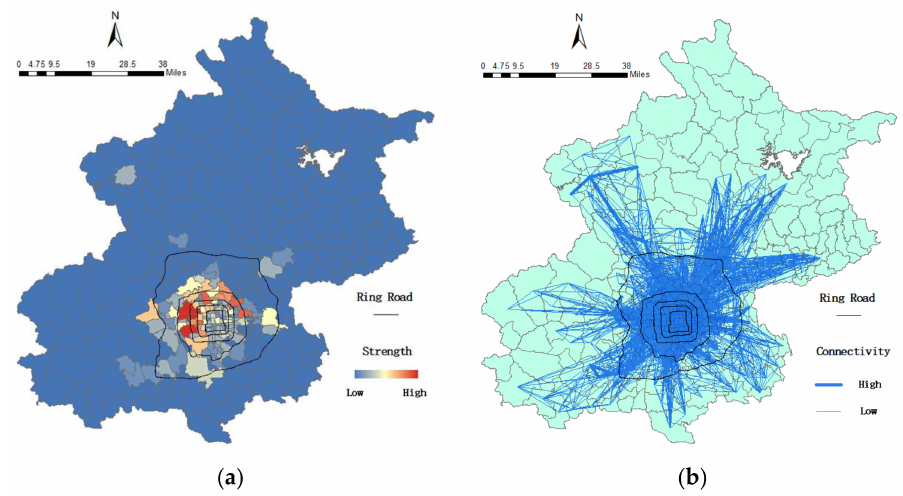
Figure 10. Strength ( a ) and connectivity ( b ) distributions in 328